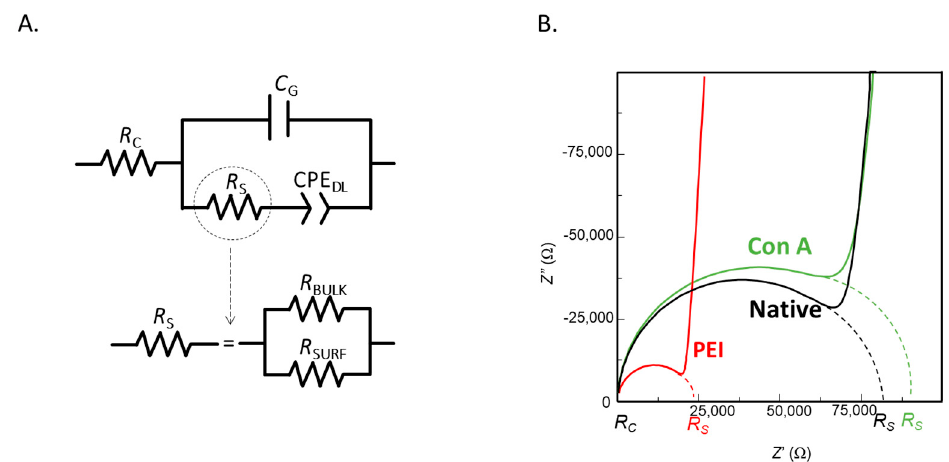
Figure 2. ( A ) Electrical equivalent circuit and ( B ) Nyquist plot of 3D-IDEA measured in 10 − 5 M KCl solution with bare electrodes and functionalized with PEI and PEI-Con A.